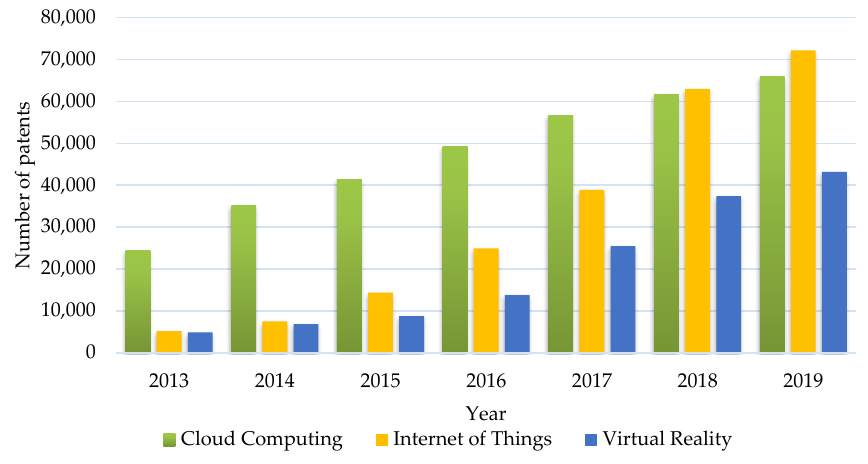
Figure 2. Number of patents by Industry 4.0 components.